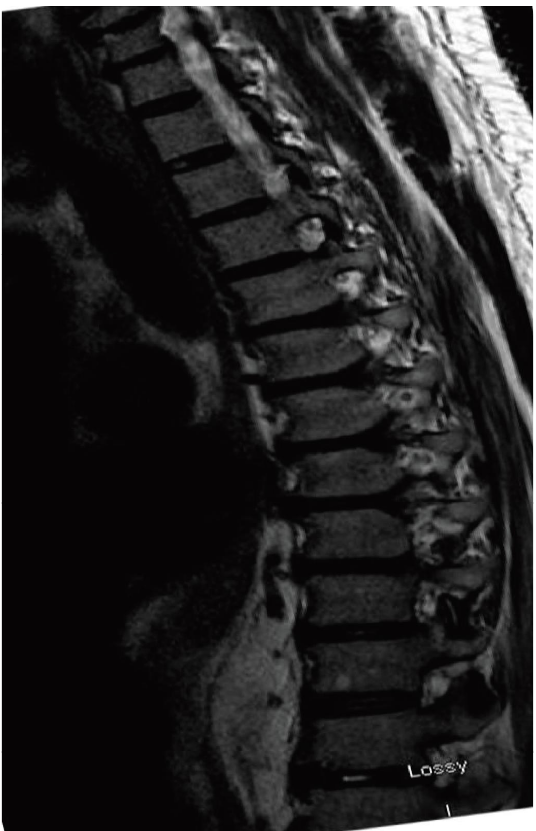
Figure 3: MRI thoracic